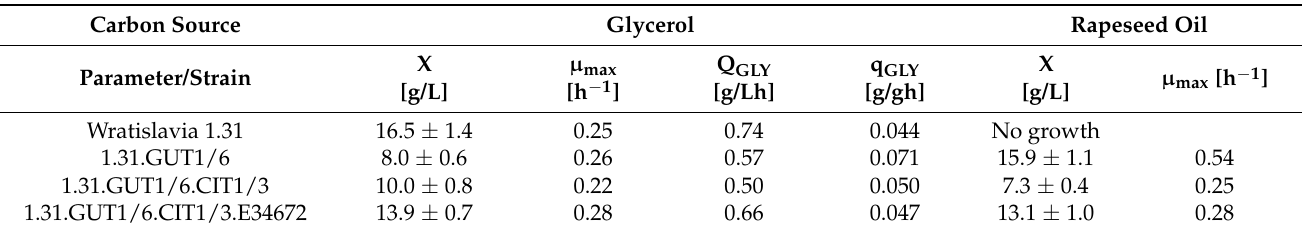
Table 1. Comparison of growth kinetic parameters of Wratislavia 1.31 and transformant strains of Y. lipolytica growing on glycerol and rapeseed